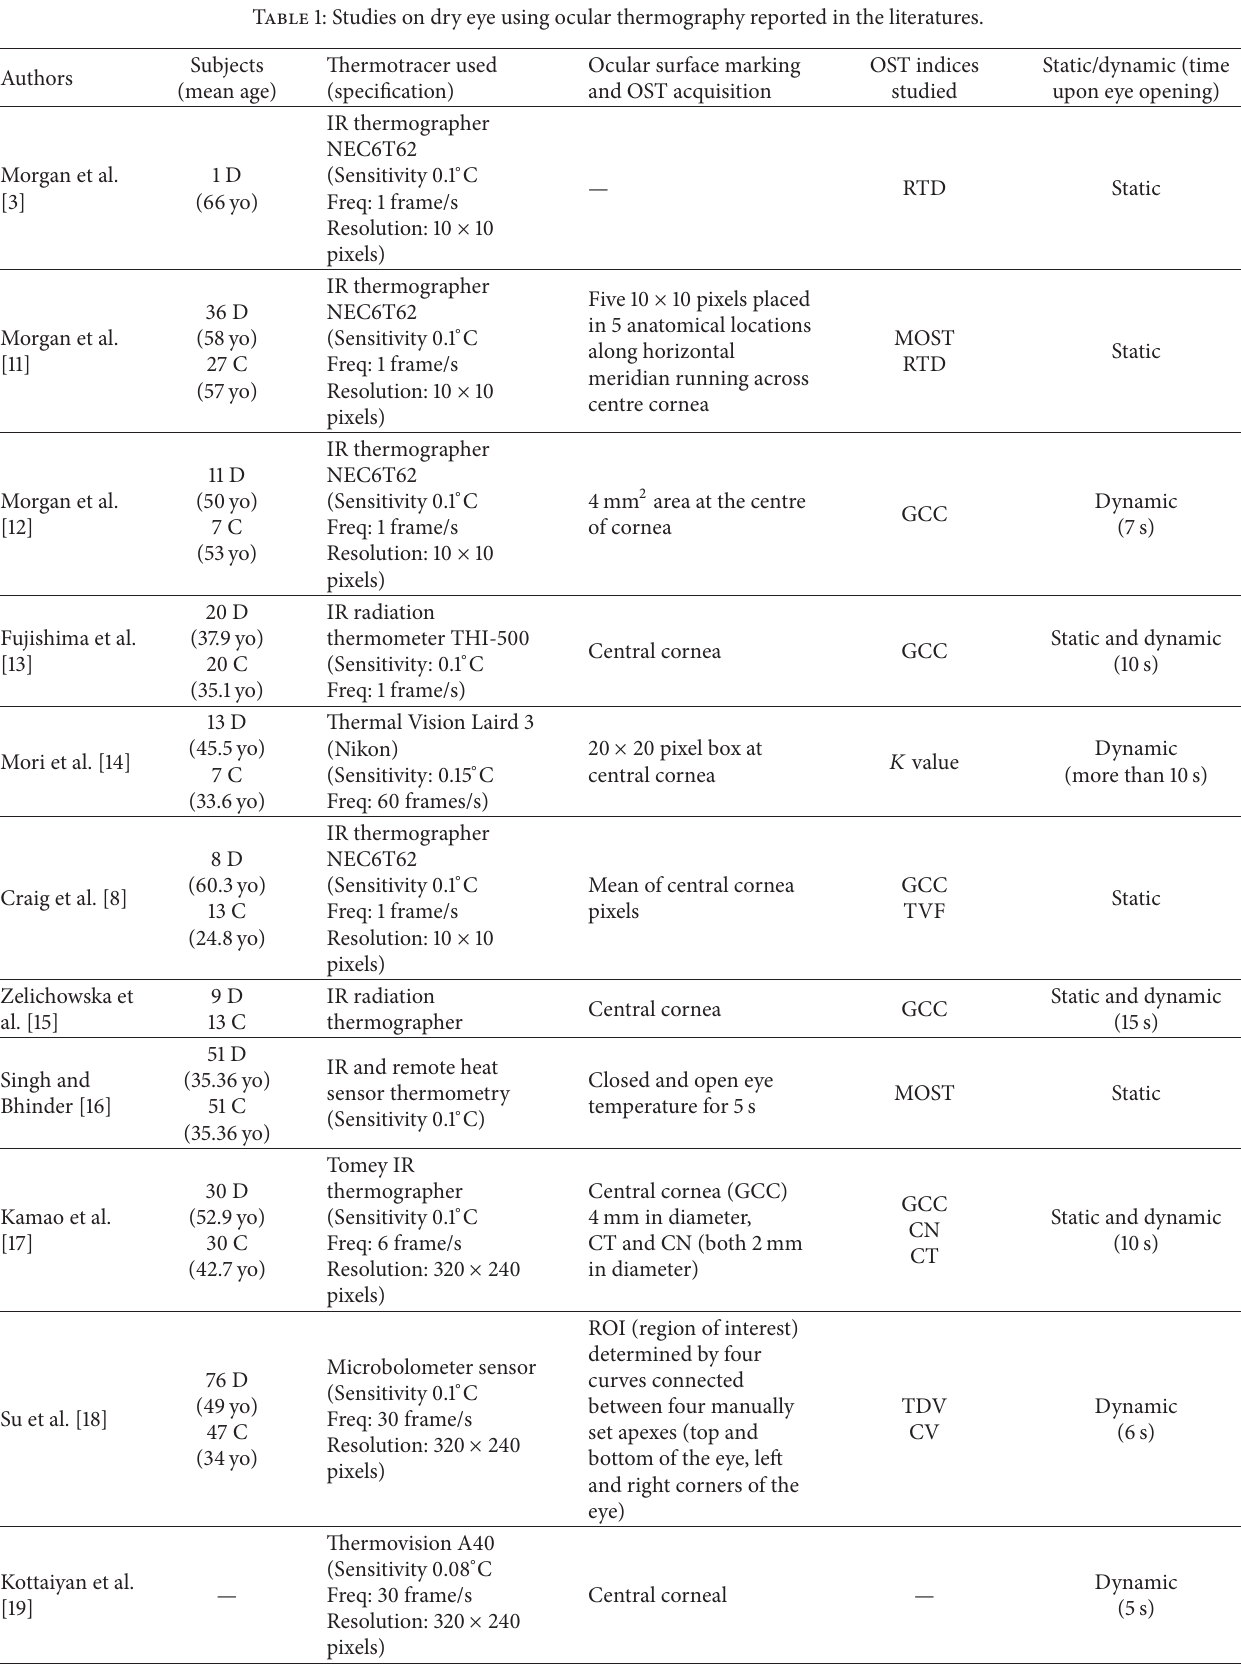
Table 1: Studies on dry eye using ocular thermography reported in the